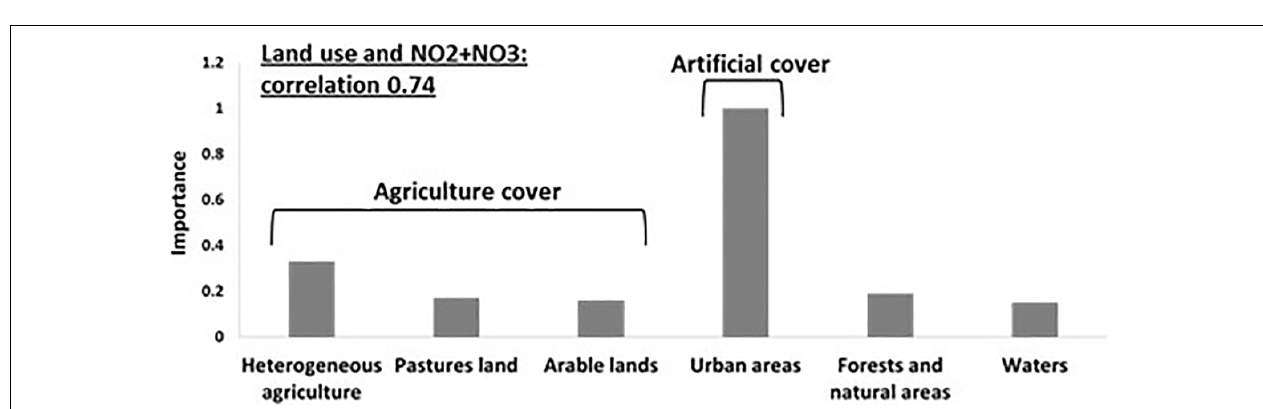
FIGURE 3 | Specific land use type affects aquatic environmental parameters: General Linear Models (GLMs) analysis were performed and resulted in Urban areas are positively related to NO 2 + NO 3 concentrations. A strong correlation ( R 2 = 0.74) is observed between land uses and nitrite and nitrate concentrations, with the fraction of “urban areas” being the most important variable contributing to the correlation.